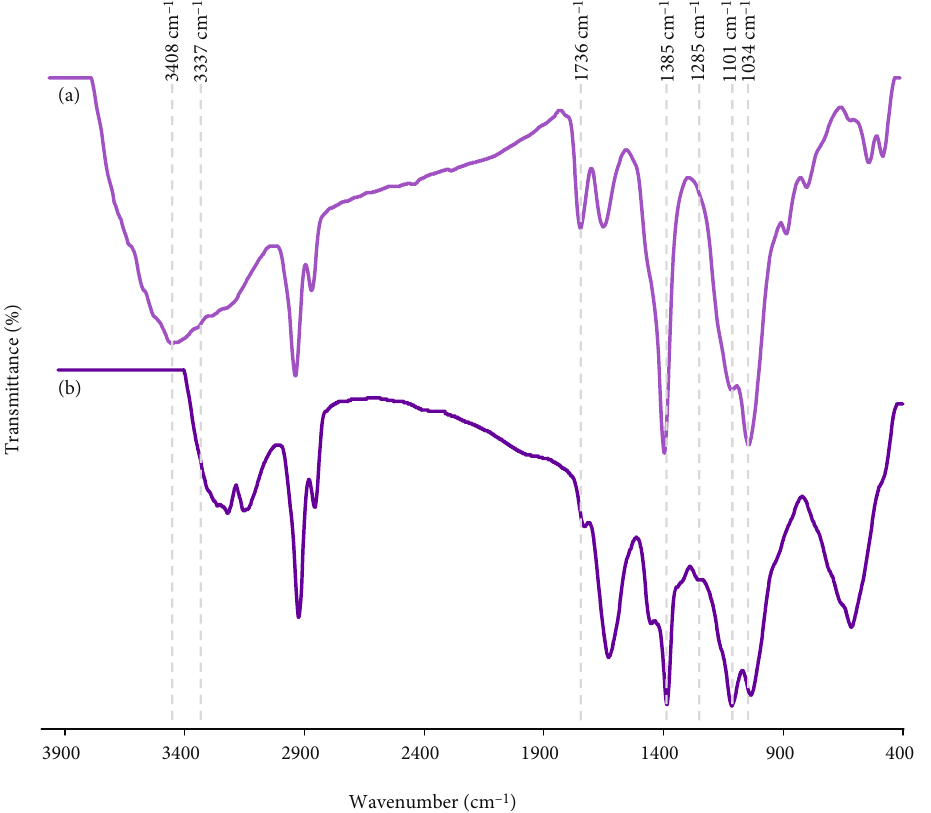
Figure 4: FT-IR spectra. (a) NGQD and (b)